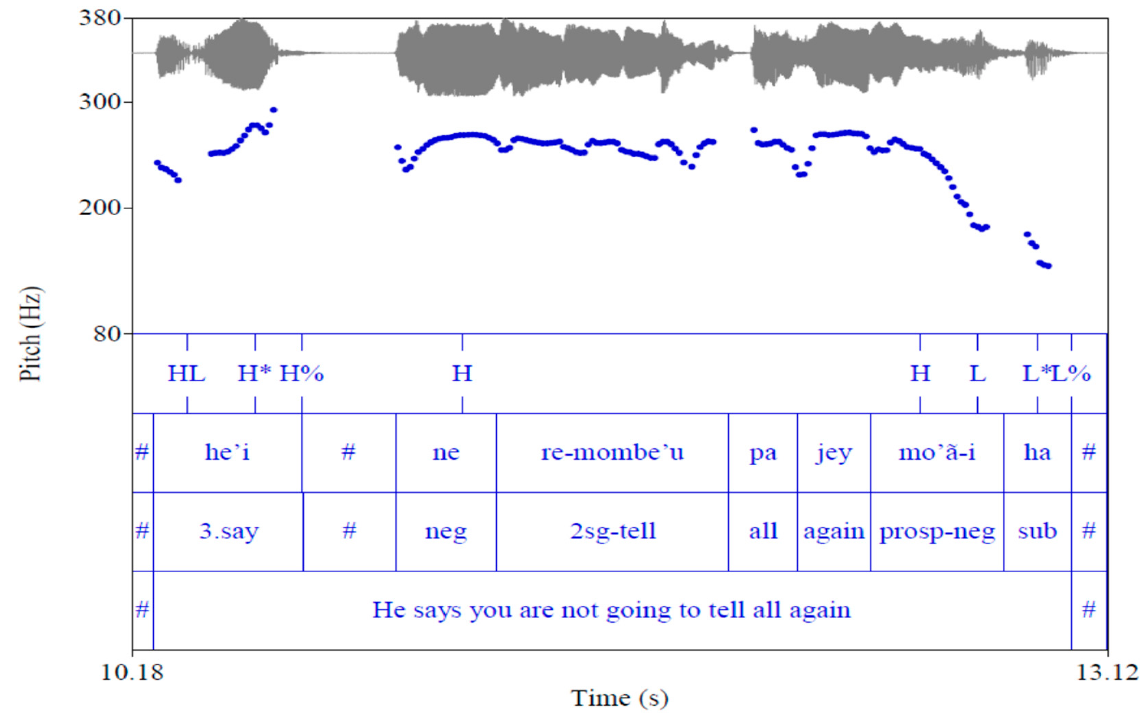
Figure 1. He’i neremombe’upa jey mo’ãiha.